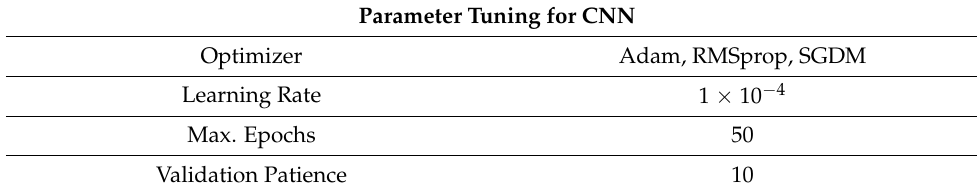
Table 4. Hyperparameters